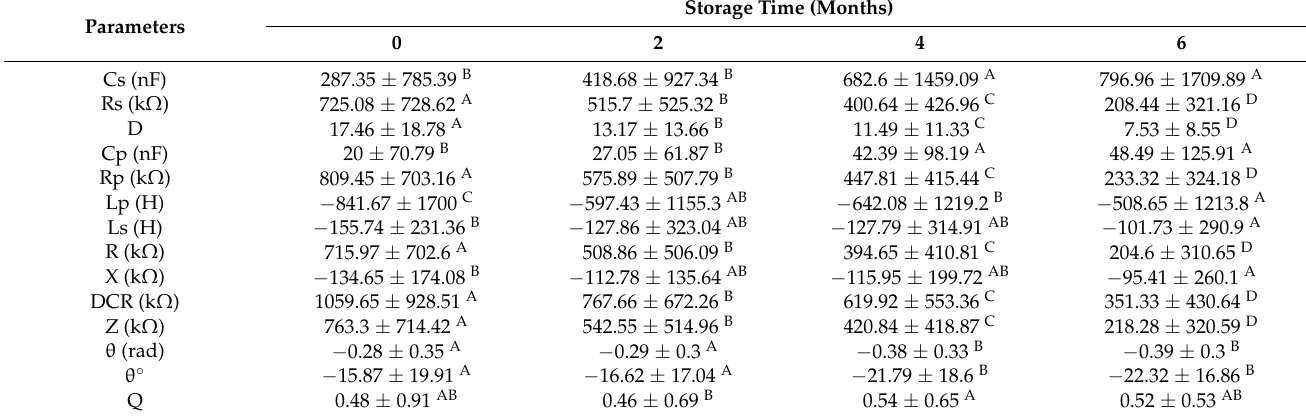
Table 4. Comparison of the mean values ± standard deviation of the electrical parameter of the stored date fruits under different cold storage